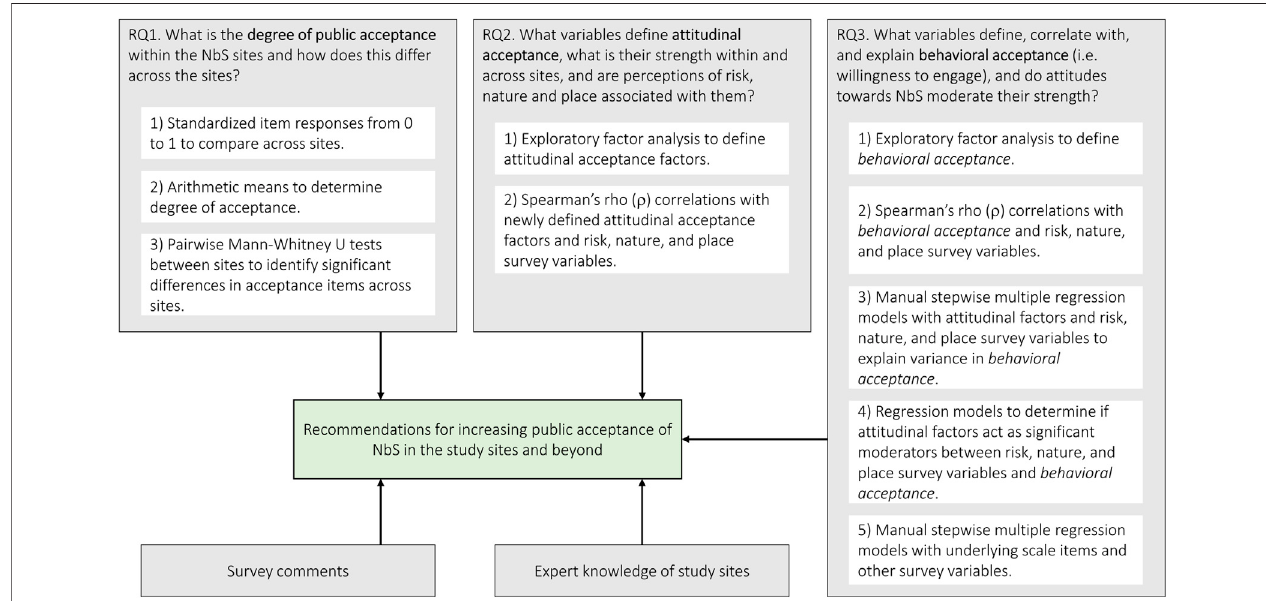
FIGURE 3| Research questions (RQ) and corresponding methods. Statistical results, combined with survey comments and expert knowledge ofthe sites, lead to recommendations for increasing public acceptance of NbS both within the study sites and for NbS generally.